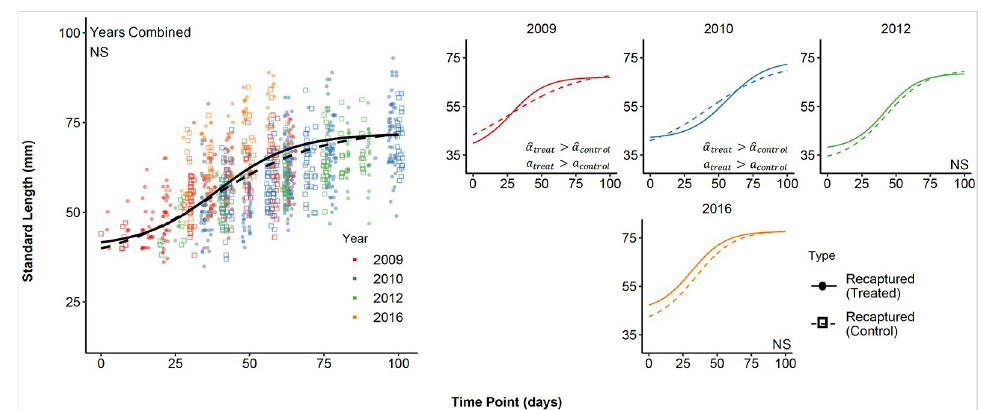
Fig 6. Growth curves based on estimated model parameters (mean of the posterior) for steelhead recaptured in restored habitat (solid lines) vs. those recaptured in unrestored habitat (dashed lines). Left panel shows data and fitted curves for all years combined; additional figures show individual years. Parameter differences (see Fig 7) are indicated in the lower right corner of each panel. The analysis omits 2013 owing to lack of long-term steelhead recaptures in unrestored